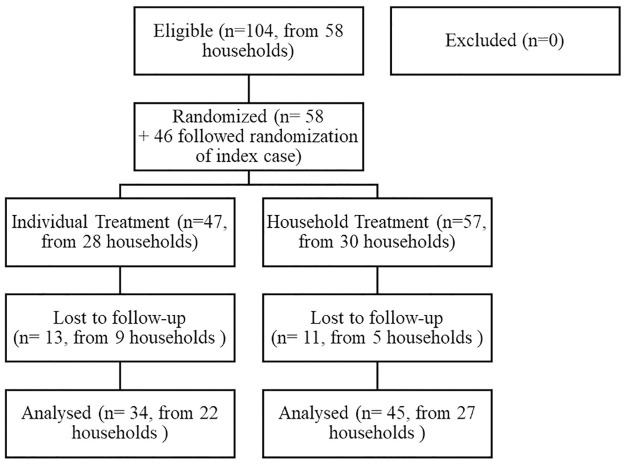
Participant flow diagram.